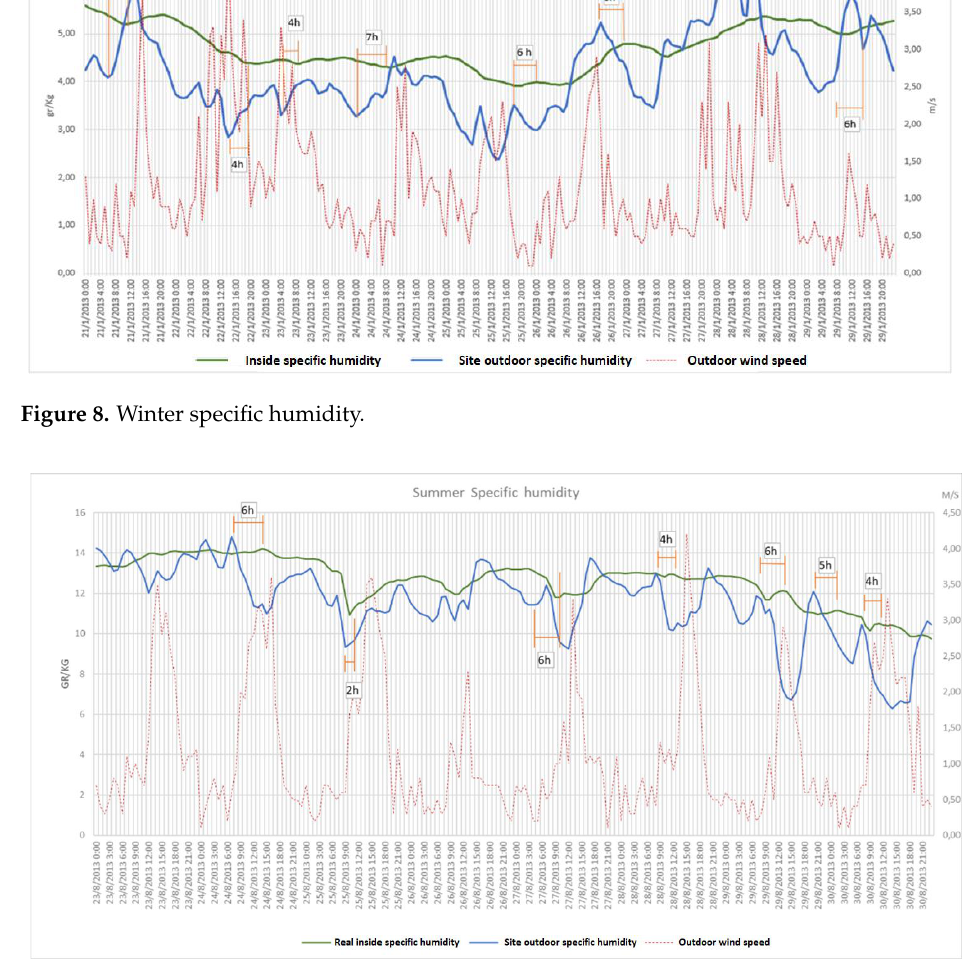
Figure 9. Summer specific humidity.